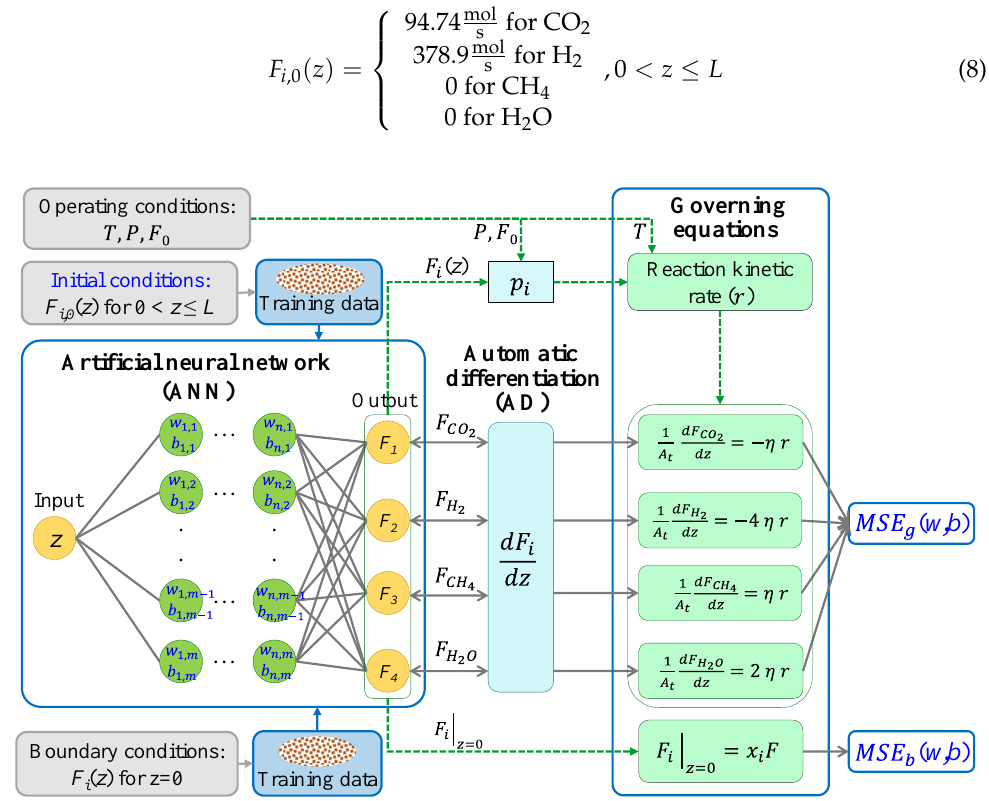
Figure 2. Architecture of the physics-informed neural network (PINN) forward problem for CO 2 methanation in an isothermal fixed-bed (IFB) reactor.